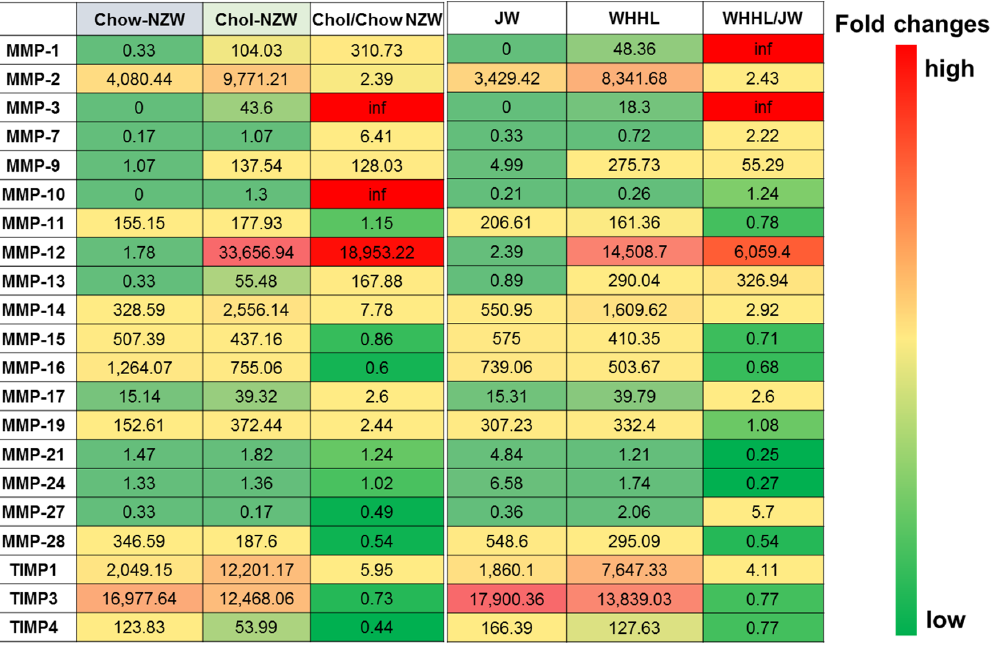
Figure 2. Heatmap of matrix metalloproteinases (MMPs) and tissue inhibitors of metalloproteinase (TIMPs) in the lesions of aortas of NZW rabbits (chow-fed versus cholesterol-fed) (left) and JW rabbits (JW wild-type versus WHHL rabbits). Average reads of four animals from each group or ratios of NZW cholesterol-fed/NZW chow-fed or WHHL/JW-chow fed are shown. Marked increases in expression were noted for MMP-12, MMP-13, MMP-9 and TIMP-1. RNA expression of MMP-1 and MMP-3 were not detected in the normal aorta. Inf means infinitive.